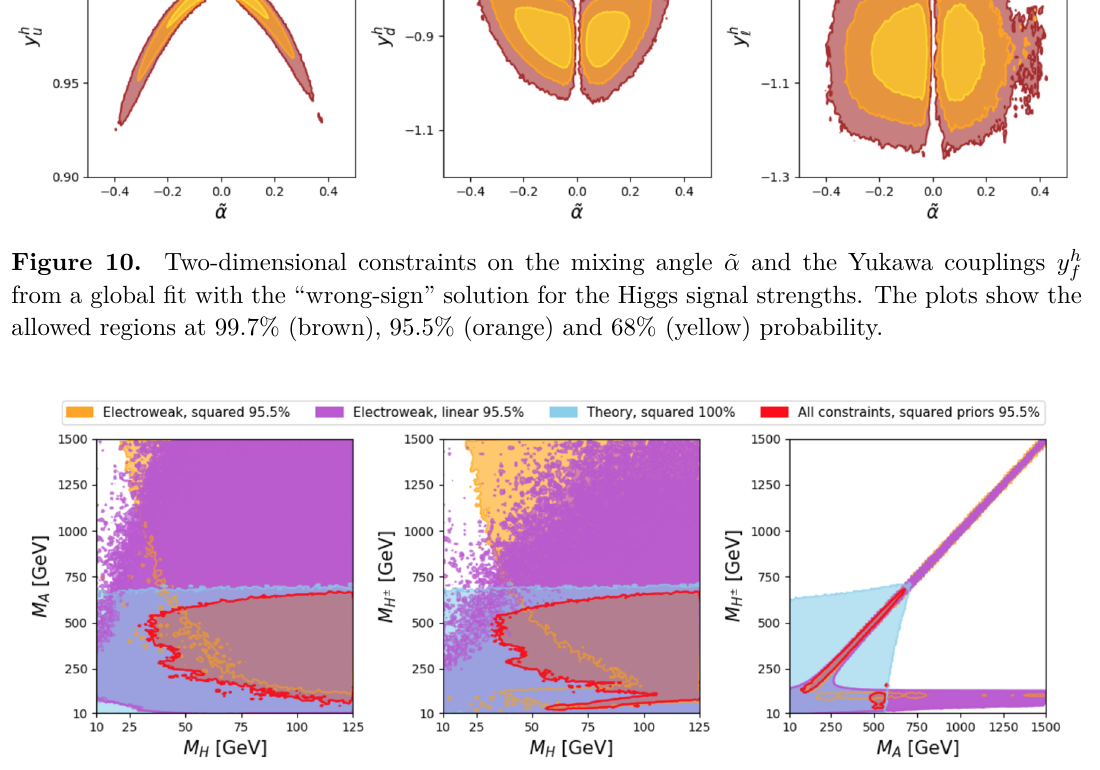
Figure 11. Two-dimensional constraints on the scalar masses in the heavy scenario. The differ- ent allowed regions correspond to theoretical constraints (blue, squared priors, 100% probability), EWPOs (95.5% probability; orange, squared priors; violet, linear priors) and the combined global fit (red, squared priors, 95.5%